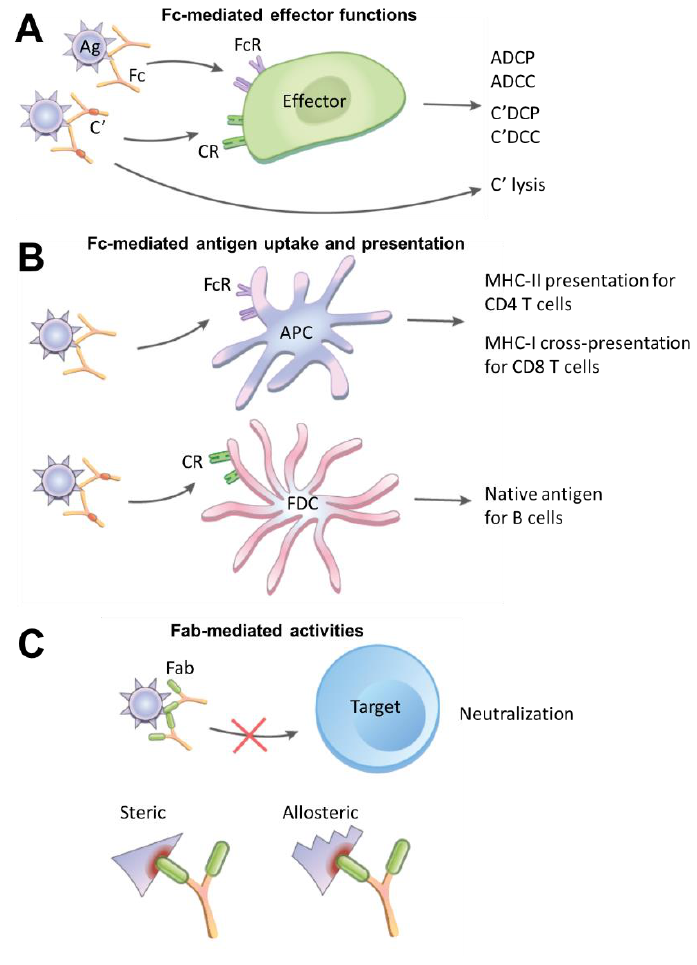
Figure 1. Fc- and Fab-mediated activities of immune complexes (ICs). ( A ) Fc-mediated effector functions for destruction of pathogens. ICs made of antibody-coated antigens (Ag) bind and cross-link Fc receptors (FcR) on effector cells such as macrophages, NK cells, and neutrophils. Interaction with FcgRIIa on macrophages, for example, can lead to IC ingestion by the antibody-dependent cellular phagocytosis (ADCP) mechanism. IC formed on virus-infected cells, on the other hand, may bind FcgRIIIa on NK cells to trigger NK cell degranulation and cause antibody-dependent cellular cytotoxicity (ADCC). In addition, ICs may activate the complement (C’) cascade to facilitate complement-dependent cellular phagocytosis (C’DCP) and cytotoxicity (C’DCC) by interacting with complement receptors (CR) on effector cells (e.g., CR3 on monocytes, CR4 on NK cells [1]) or to induce direct complement-mediated lysis. ( B ) Fc-mediated antigen uptake and presentation. ICs interact with FcRs, either type I (FcgRI, FcgRII, FcgRIII) or type II (DC-SIGN and CD23), on antigen-presenting cells (APCs) to promote antigen uptake. The APCs proteolytically process antigens for major histocompatibility complex (MHC)-II presentation to helper CD4 T cells and for MHC-I cross-presentation to cytotoxic CD8 T cells. Alternatively, ICs are opsonized with complement and captured by follicular dendritic cells (FDCs) via CR1 and CR2 on the FDC surface. The FDCs preserve native Ags in the form of ICs and present them to B cells. ( C ) Fab-mediated activities. Antibodies that bind pathogens and form ICs with their Fab fragments can neutralize the pathogens to prevent infection of target cells. Fab-mediated binding also imposes steric hindrance which alters the accessibility of specific antigenic epitopes on ICs. In addition, Fab-antigen interactions may induce allosteric alterations, resulting in increased or decreased structural stability, flexibility, or exposure of certain epitopes on ICs.